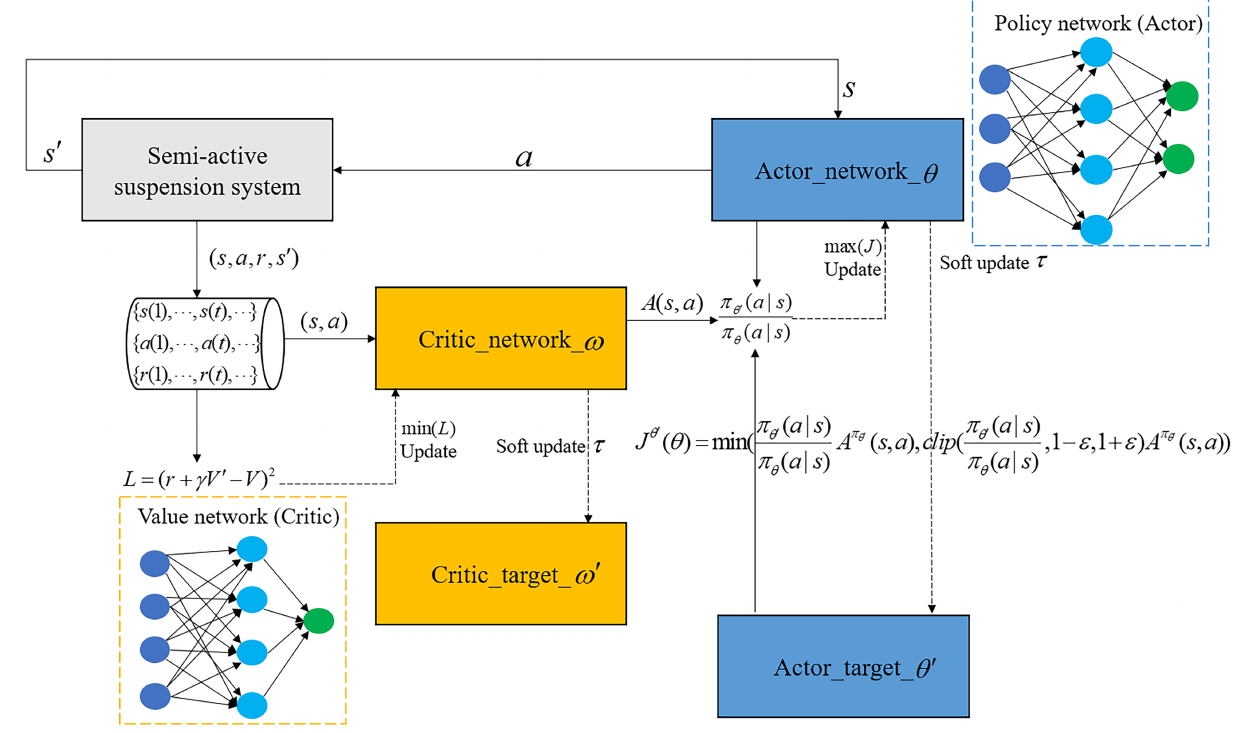
Figure 4. The PPO algorithm’s